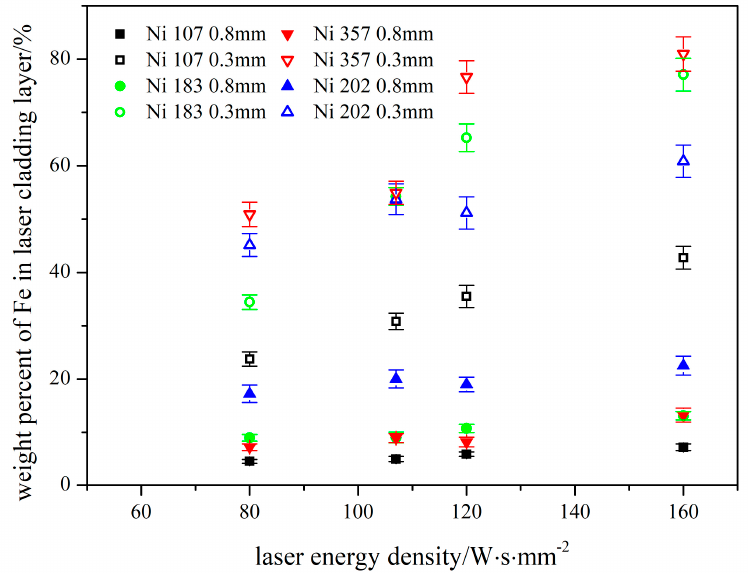
Figure 6. Weight percent of Fe in laser cladding layer. In this picture, the color represents the number of Ni-based alloy powders: Black-Ni 107, green-Ni 183, blue-Ni 202 and red-Ni 357. The empty point represent the thickness of pre-placed powder layer (0.3 mm), and the solid point represent the thickness (0.8